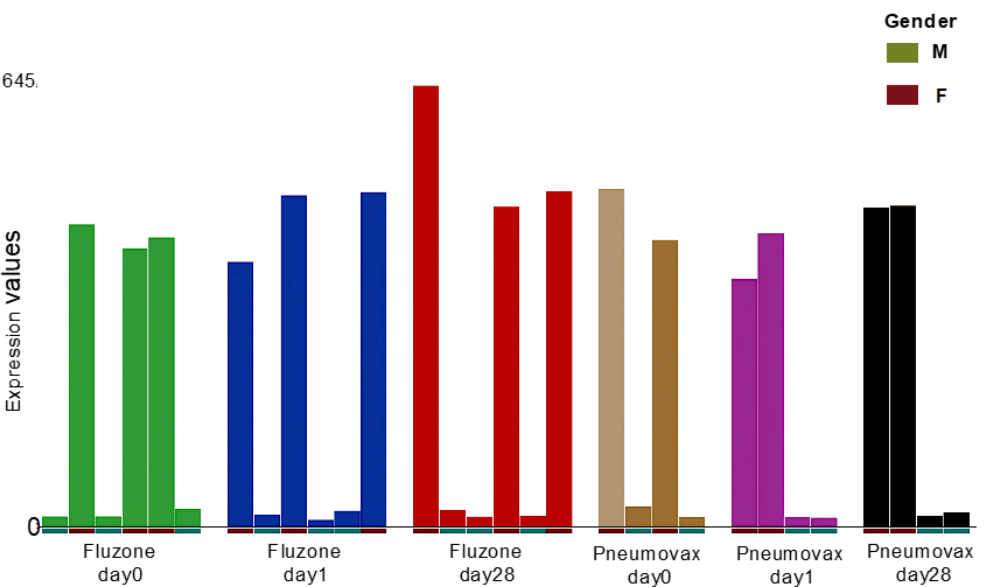
Figure 2. Shown are XIST gene expression levels and gender information from the venipuncture validation set of GSE48762. Gene expression data were from whole blood of healthy adult volunteers before and after receiving either placebo (saline) injections, seasonal influenza (Fluzone) or pneumococcal (Pneumovax)